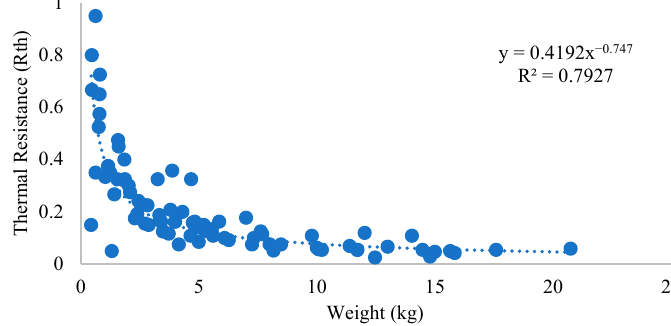
Figure 12. Thermal resistance of the heatsink according to its weight. The thermal resistance parameter of the heatsink is expressed by its weight according to Equation (14).